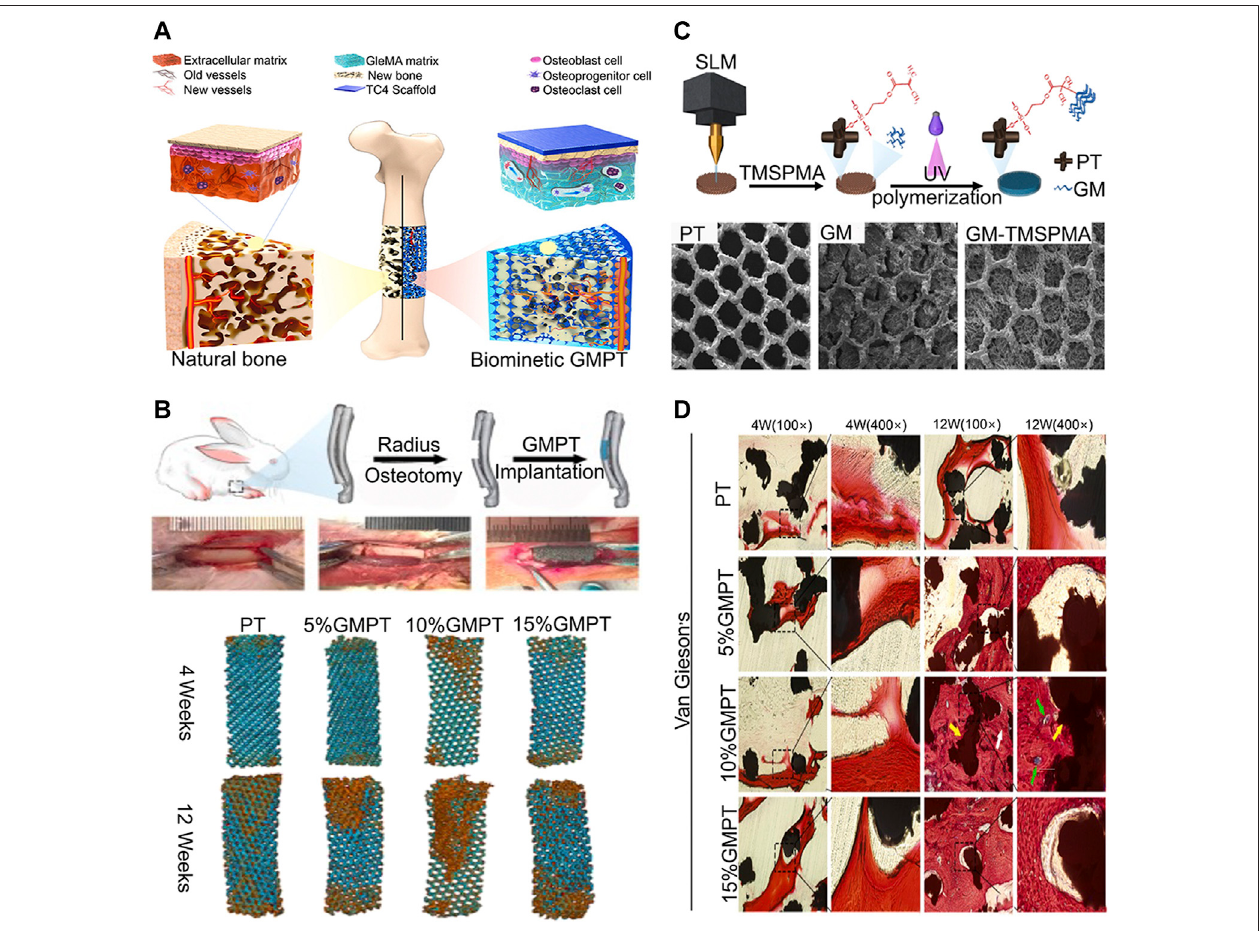
FIGURE 4 | Ti6Al4V alloy/GelMA hybrid implant with dual bionic features (GMPT) for bone defect repair (Ma et al., 2021). (A) Schematic illustrations of the biomimetic GMPT with dual-bionic features. (B) In situ implantation of PT and GMPT implants, micro-CT 3D reconstruction of PT and GMPT in critical radius defects of rabbits. The implants in GMPT group had higher osteogenic activity than uncoated implants, and the osteogenic ability of the 10% GMPT group was the strongest. (C) The fabrication process and characterization of GMPT. (D) Histological analysis of implant samples after 4 and 12 weeks in rabbit radius defect sites. The GMPT group showed thicker and higher number of trabeculae than the PT group at both weeks 4 and 12 (yellow arrows indicate the PT implant, white arrows indicate new bone, and green arrows reveal new vessels). The 10% GMPT group showed the best osteogenesis and angiogenesis ability.